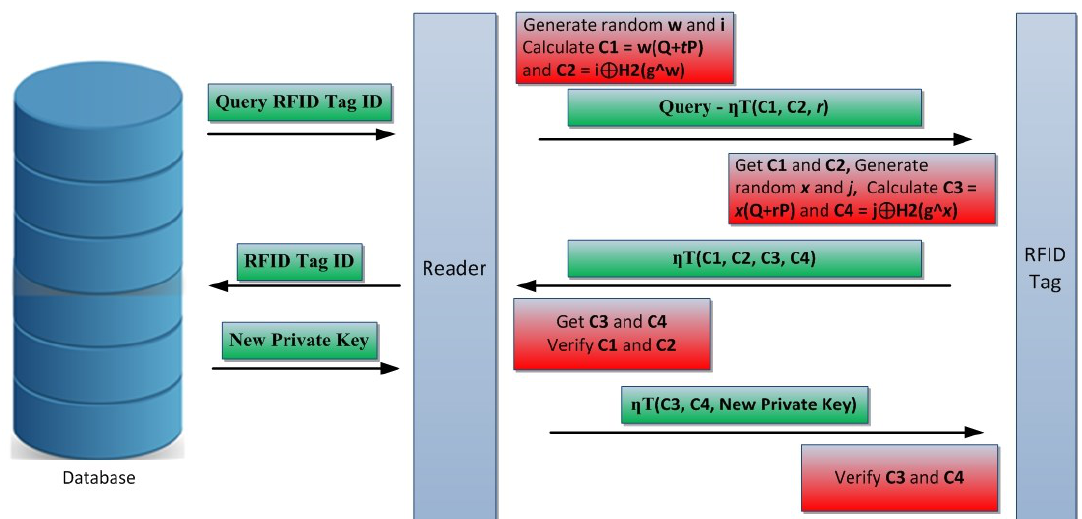
Figure 2 . Three-way handshake of the key management